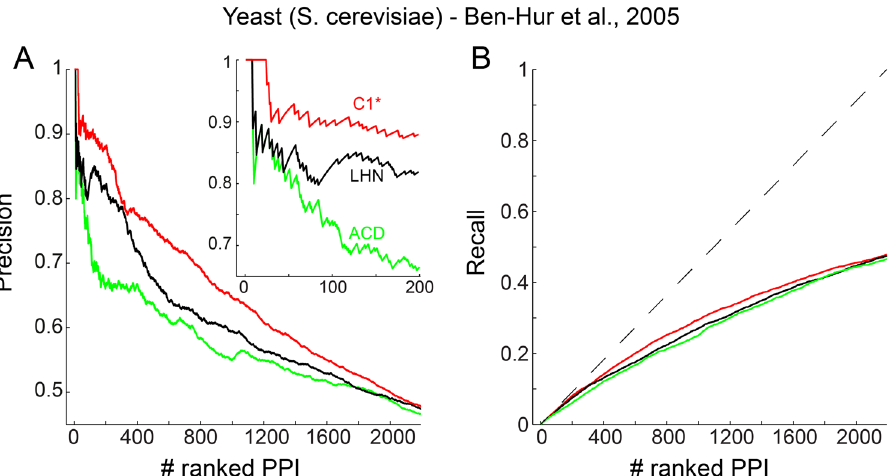
Figure 2. ( A) Precision curves of the first-ranked methods (the first for each of the three considered classes) in network 1 considering the first 2000 ranked PPI. Inset on the upper-right of the figure reports the enlarged curves for the first 200 ranked interactions. ( B) Recall curves of the same aforementioned methods. The dashed line indicates the best possible